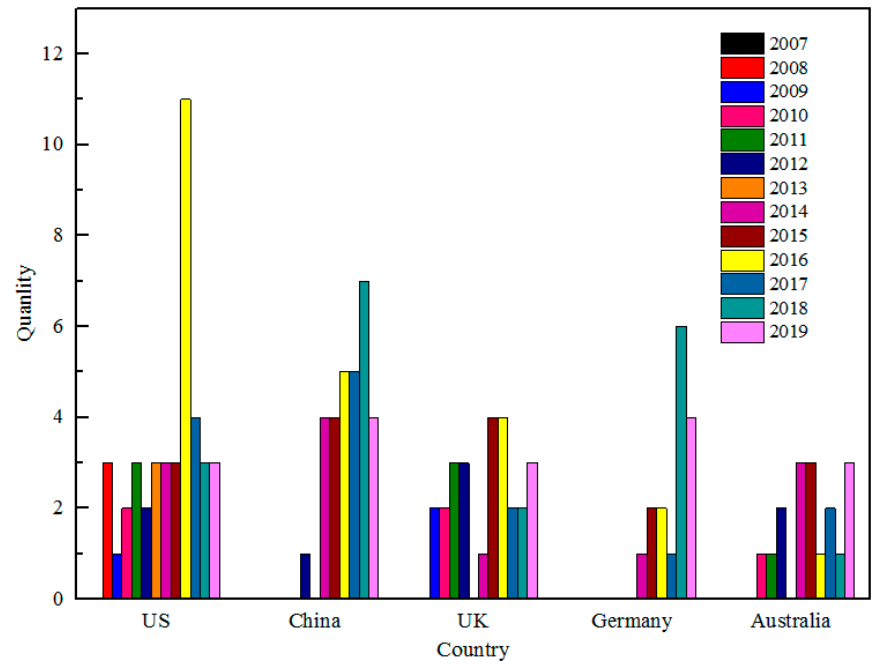
Figure 2. Number of publications regard the top five countries.